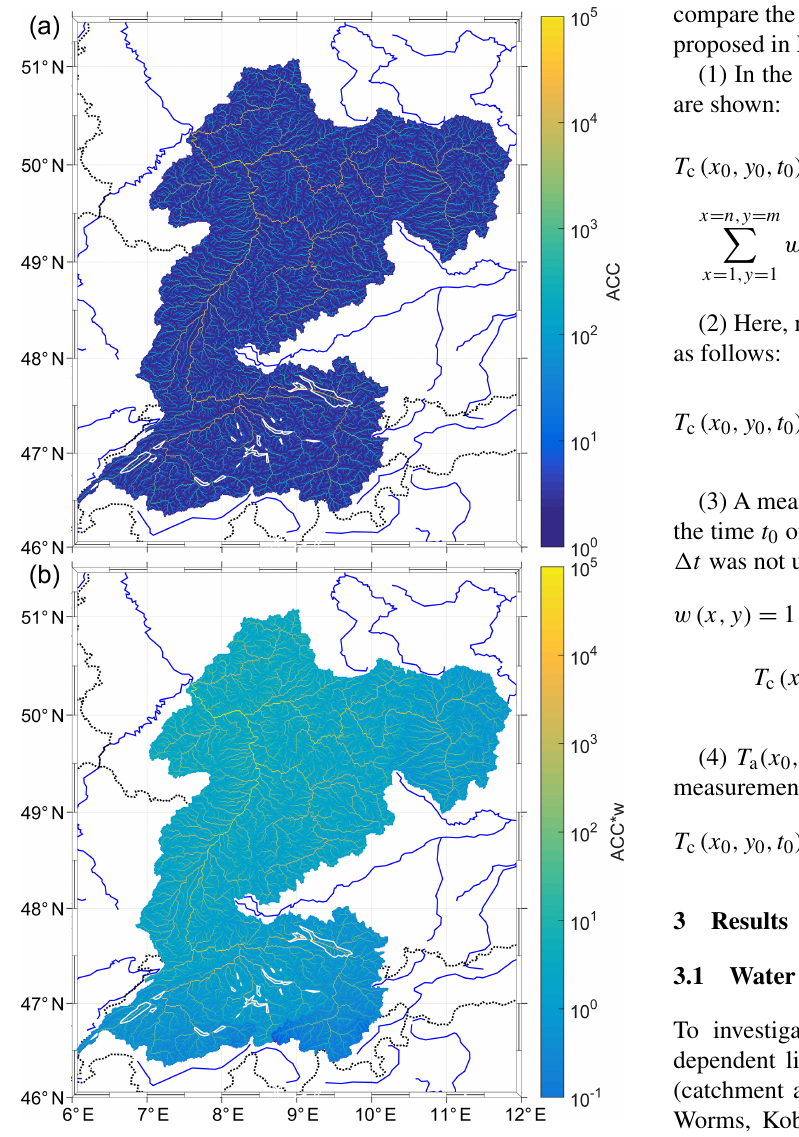
Figure 3. The catchment area of the Koblenz monitoring station. (a) Number of grid points (accumulation number – ACC) which are upstream of each specific grid point. (b) ACC · w , distance and ACC-weighed grid